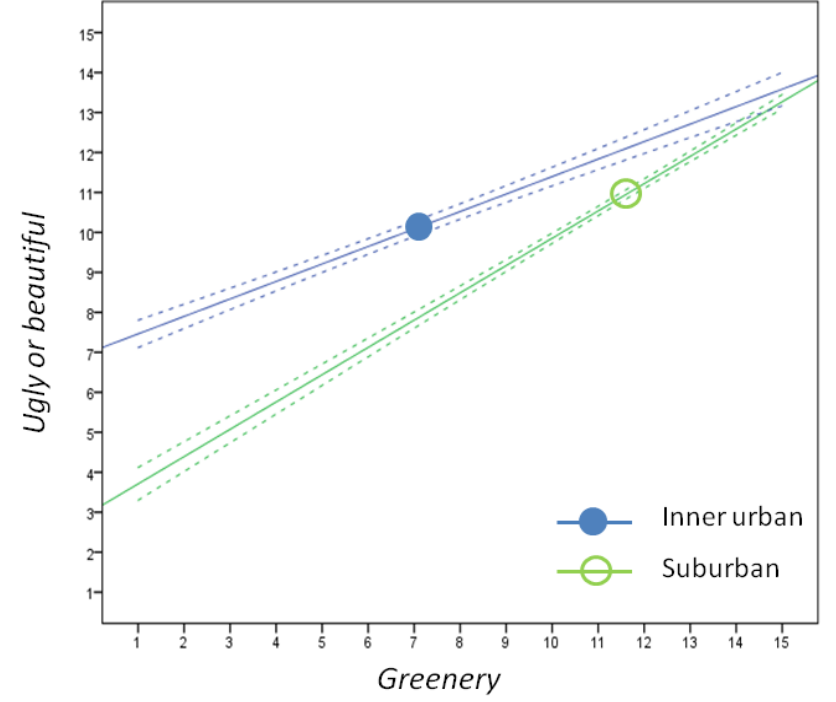
Figure 2. The relationship between ratings of ugly or beautiful and greenery in the inner urban and suburban areas. Y-axis: Ugly or beautiful : “How ugly/beautiful do you find the surroundings along your route?” (1 = very ugly and 15 = very beautiful), and x-axis: Greenery : “How do you find the availability of greenery (natural areas, parks, planted items, trees) along your route?” (1 = very low and 15 = very high) The upper blue lines represent the inner urban areas [15]. The lower green lines represent the suburban areas. The solid lines represent the regression lines and the dashed lines represents the 95% confidence intervals (CI) (Inner urban: y = 7.02 (6.64 – 7.41) + 0.44 (0.39 – 0.48) x, (95% CI), and suburban: y = 3.03 (2.58 – 3.47) + 0.68 (0.65 – 0.72) x). Pearson’s correlation was for: inner urban: 0.54 (n = 822); and suburban: 0.73 (n = 1104). The blue filled dot represents the mean values for greenery and ugly or beautiful in the inner urban environment (7.1 and 10.1, respectively) ( cf. [15]). The green non-filled dot represents the corresponding values for the suburban environment (11.4 and 10.8, respectively) in the present study (see Table